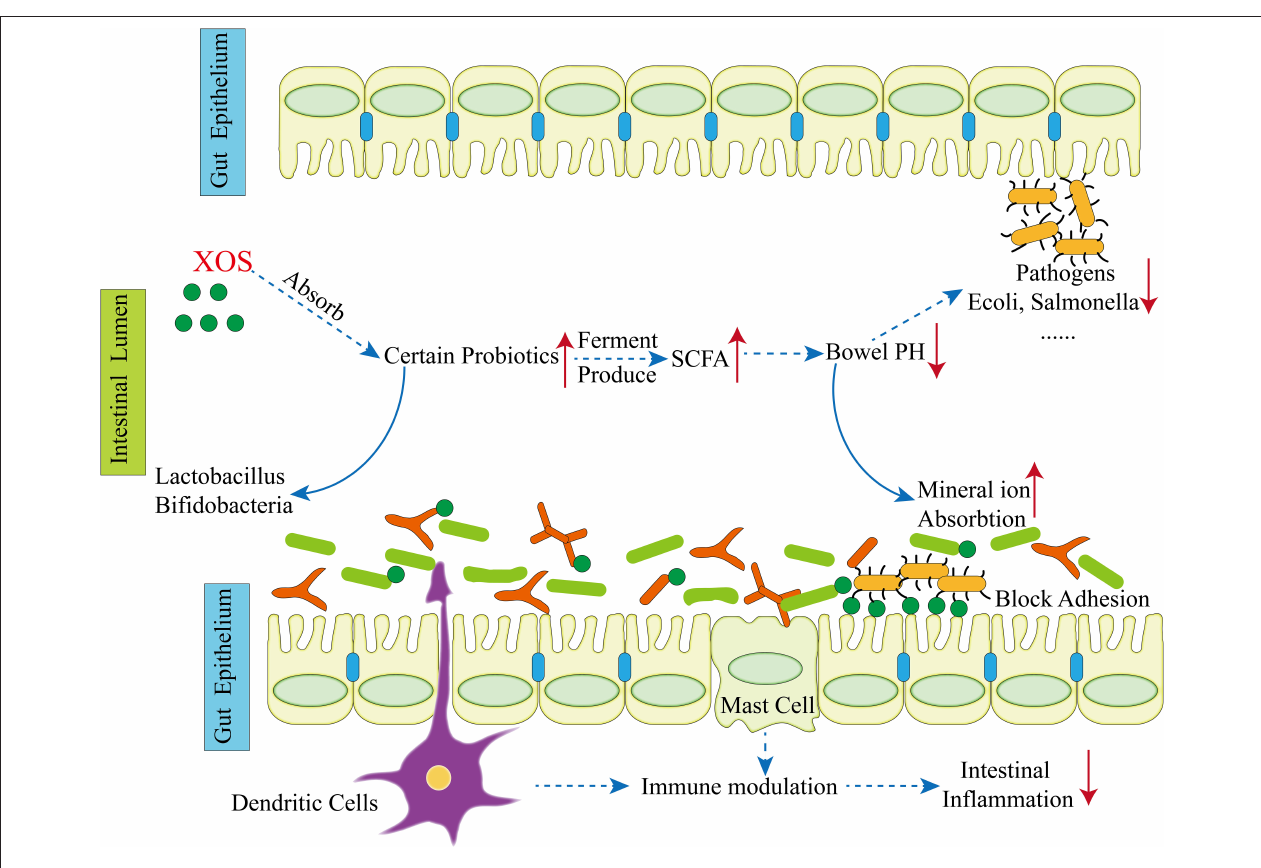
FIGURE 4 | Potential health benefits of prebiotics [quoted from